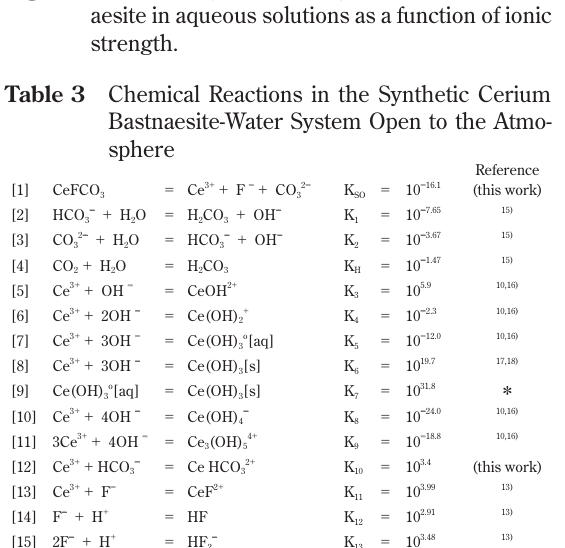
Fig. 5 Equilibria in the synthetic cerium bastnaesite / water system open to the atmosphere at 25 ℃ .